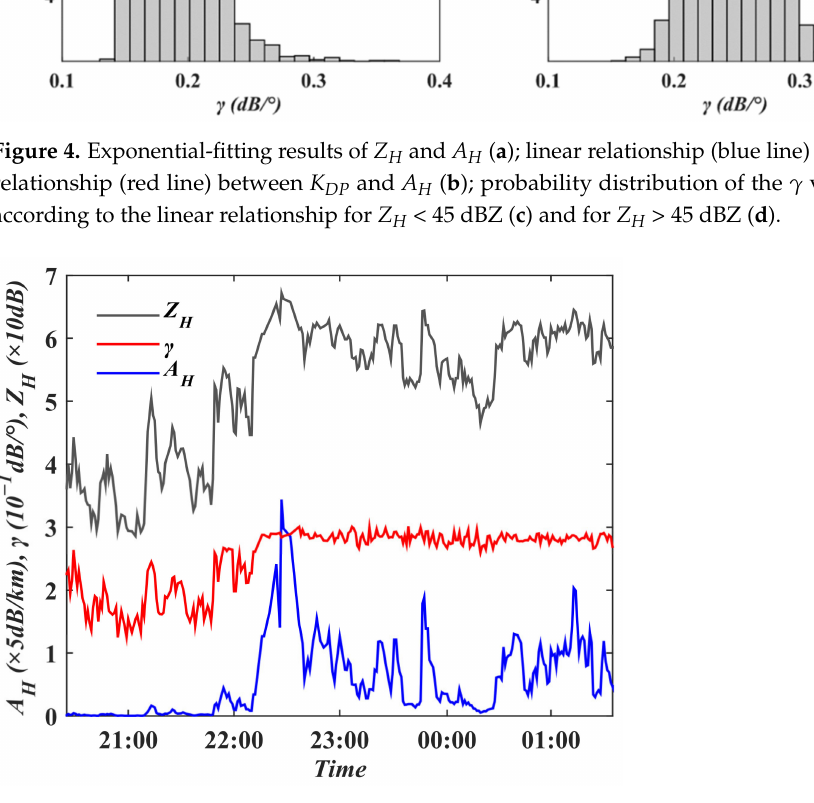
Figure 5. Simulated polarimetric variables and A H based on DSD measurement in typical rainfall